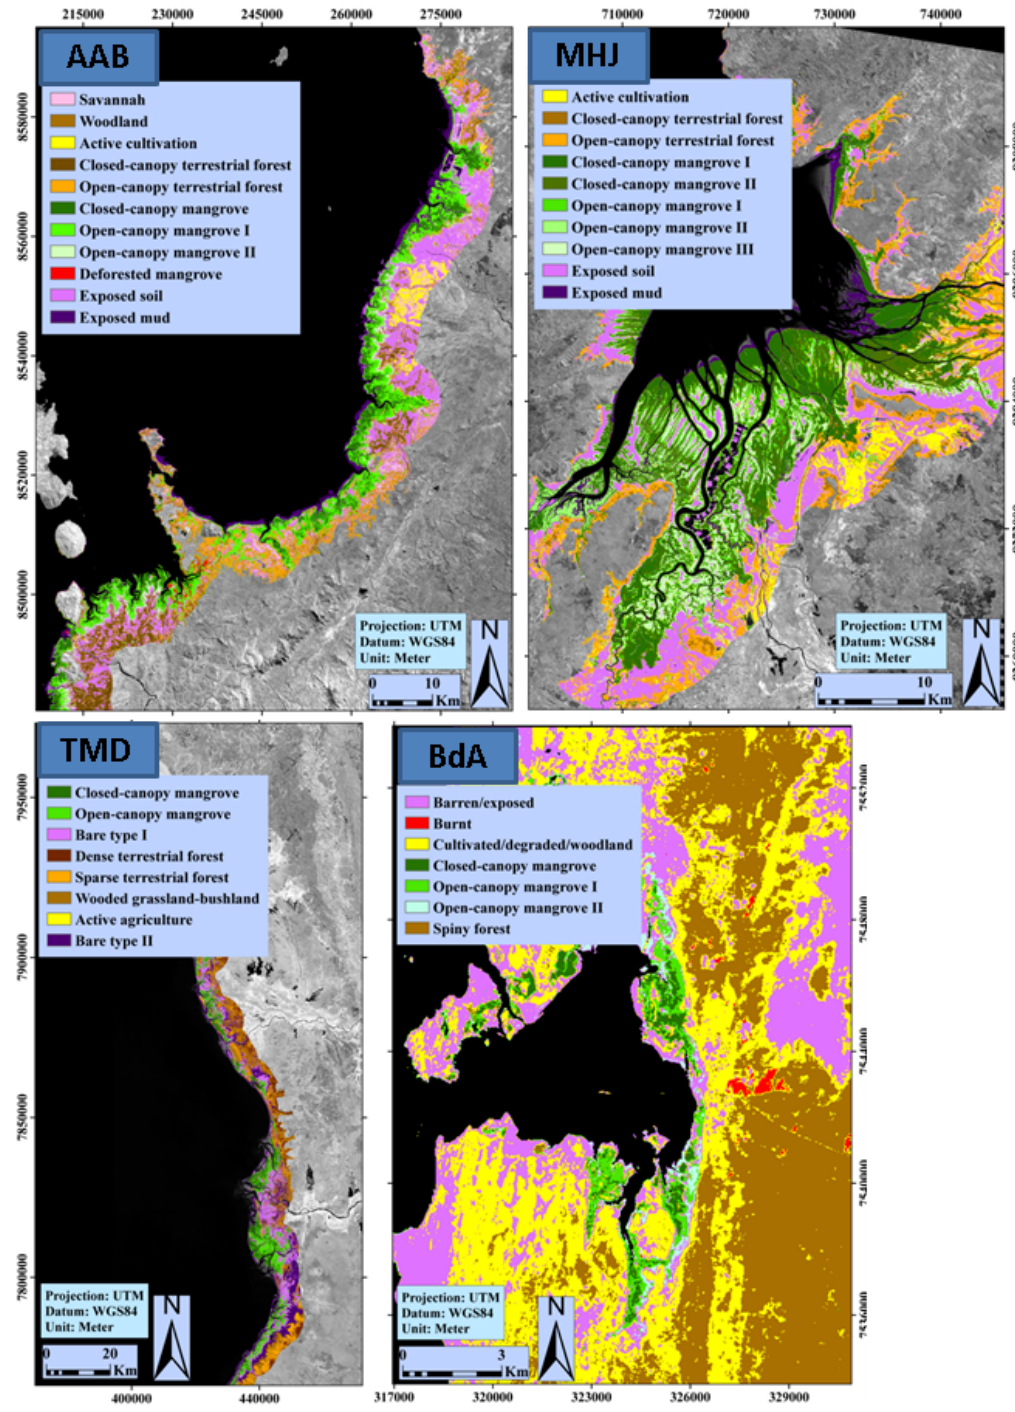
Figure 7. The results of detailed, contemporary, ecosystem-level mapping for four AOIs ( i.e. , Ambaro-Ambanja Bays (AAB), Mahajamba bay (MHJ), Tsiribihina Manambolo Delta (TMD), and Baie des Assassins (BdA)). The water dominated class is excluded for BdA and is excluded from the figure. For each AOI, the background image is a Landsat NIR band ( i.e. , band 4: Landsat 5 TM and Landsat 7 ETM+ ; band 5: Landsat 8 OLI) as described in Table 2. Mapping results for AAB and MHJ were originally presented in Jones et al. [25] and Jones et al. [61].